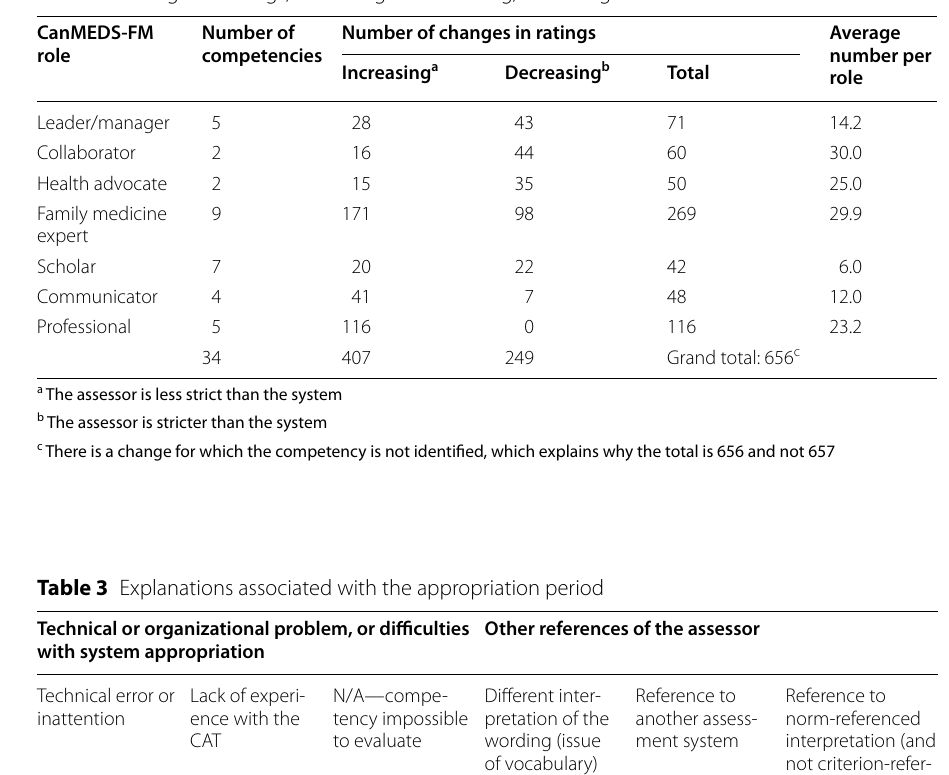
Table 2 Changes in ratings, increasing or decreasing, according to the